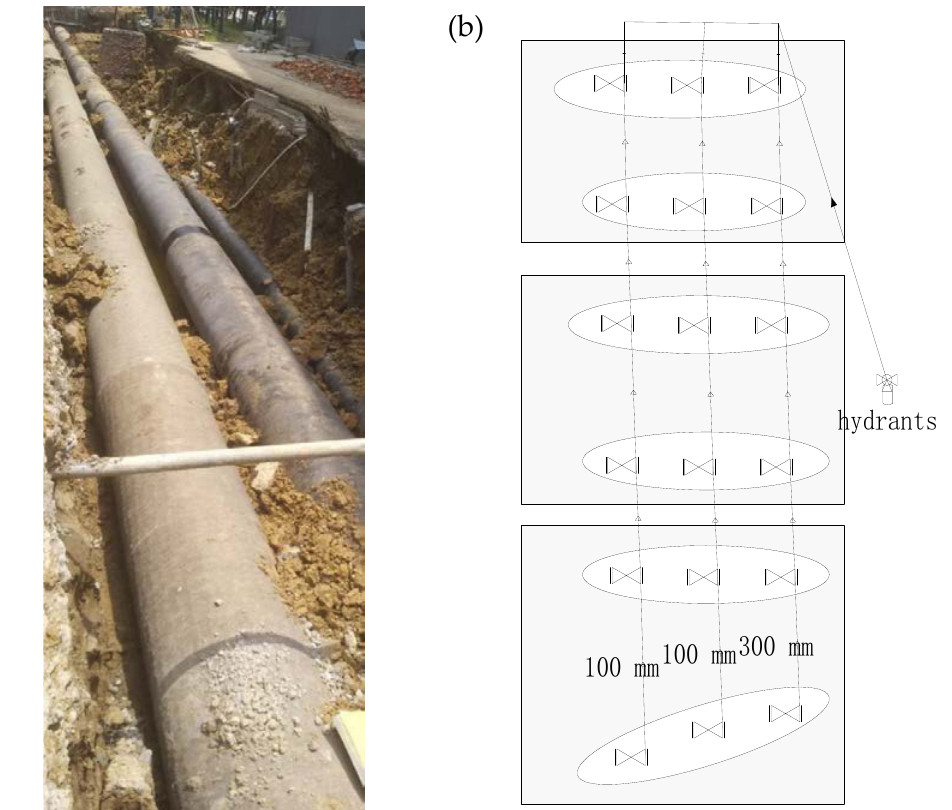
Figure 3. Pipe rig layout: ( a ) photograph showing the test rig under construction; ( b ) schematic of three test pipes.